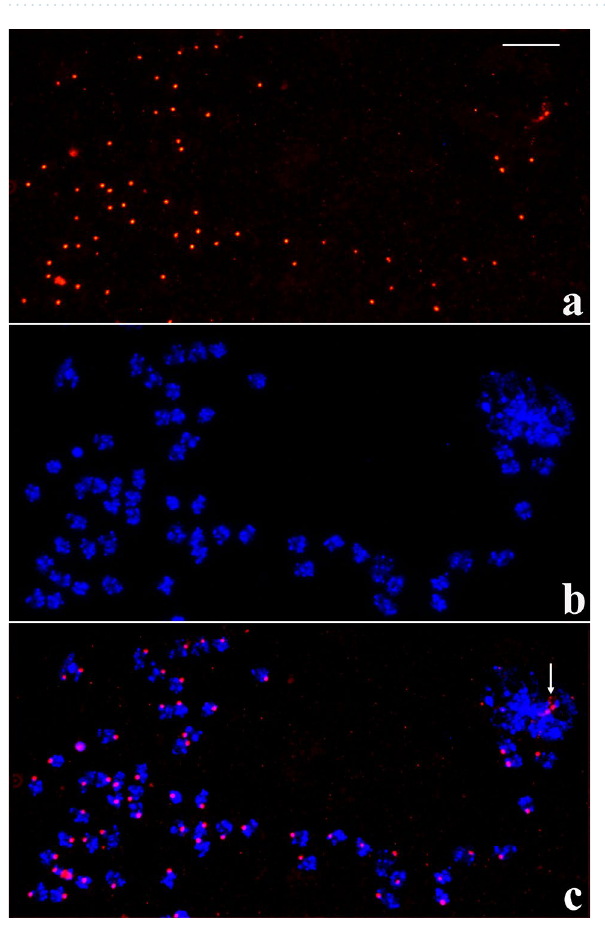
Figure 6. ( a–c ) Localisation of the rDNA in Schwenkfeldina sp. neuroblast nuclei showing RNA probe signals ( a ), its corresponding DAPI staining image ( b ) and the merged signals ( c ). Usually, a single rDNA signal is detected in diploid nuclei. The arrow points to a polytene chromosome set showing a low rDNA dispersion degree. Bar = 50